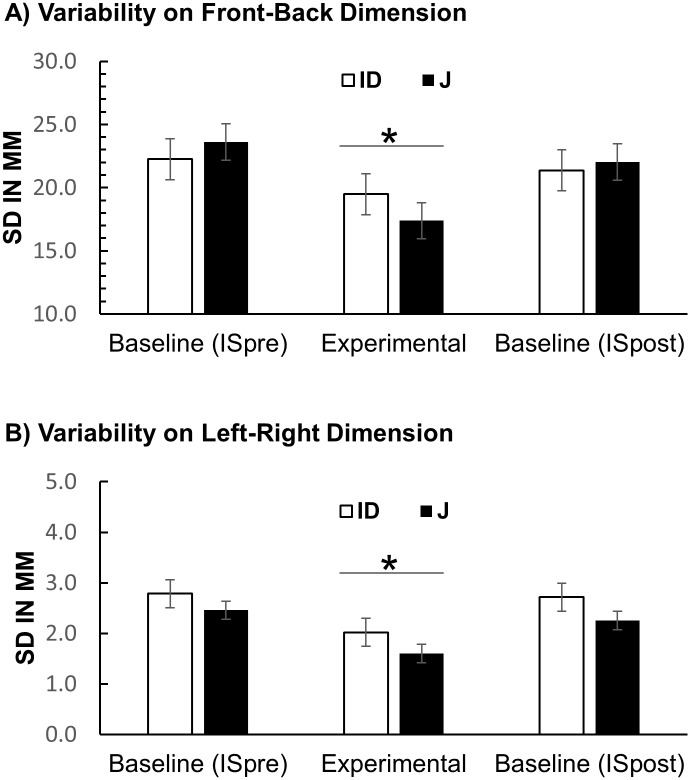
Results of Experiment 2: Variability of judgment errors.(A) Variability on egocentric front-back dimension. (B) Variability on egocentric left-right dimension. Error bars stand for within-subject 95% CI.